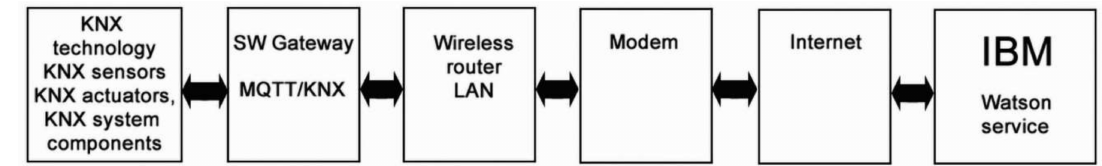
Figure 4. Block diagram of created SW connection between KNX technology on the building of new FEI VSB-TU Ostrava and IBM IoT Watson platform